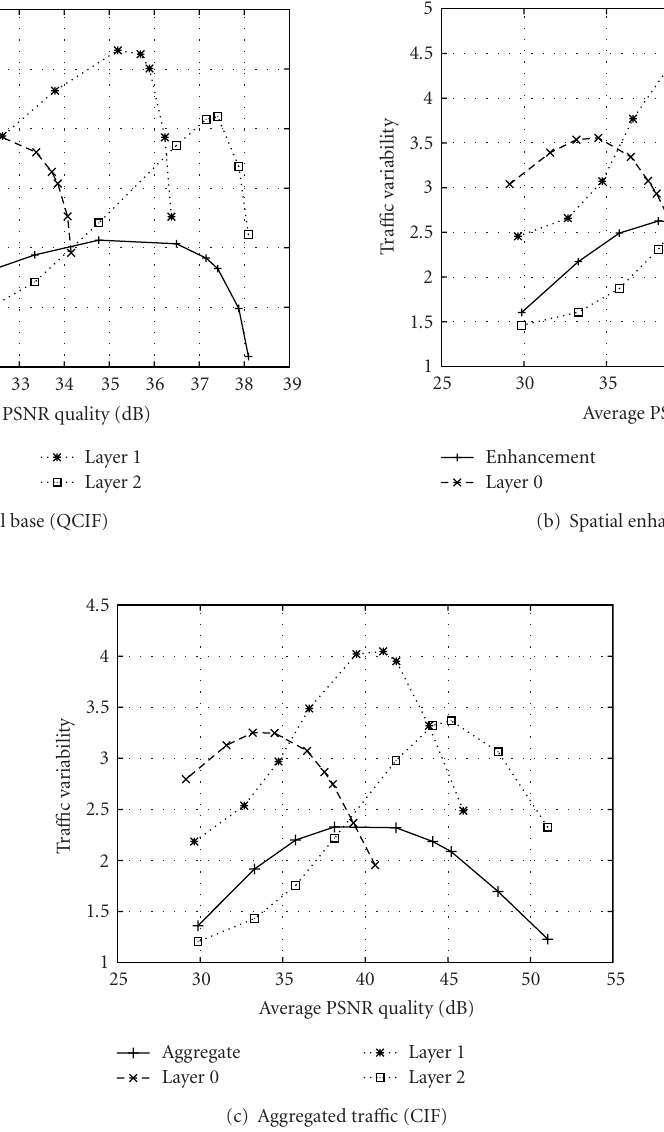
Figure 9: VD curves of all temporal layers ( 0 , 1 , 2 ) embedded in each spatial layer and in the aggregated (base + enhancement) tra ffi c stream, for the Silence of the Lambs sequence encoded with H.264 SVC ( G16-B3